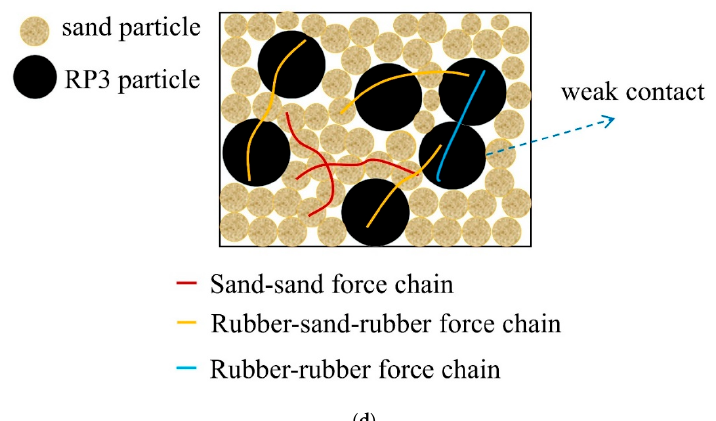
Figure 15. Schematic diagram of internal contact and force transmission chains in ( a ) pure sand; ( b ) SRP1; ( c ) SRP2; ( d ) SRP3.